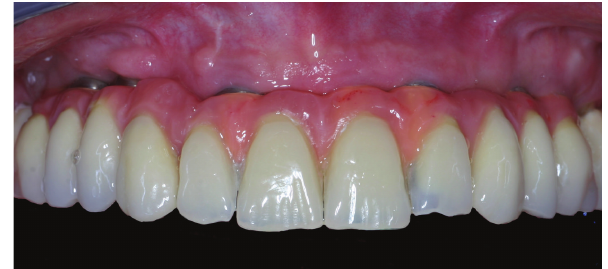
Figure 7: Final screw-retained implant prosthesis.